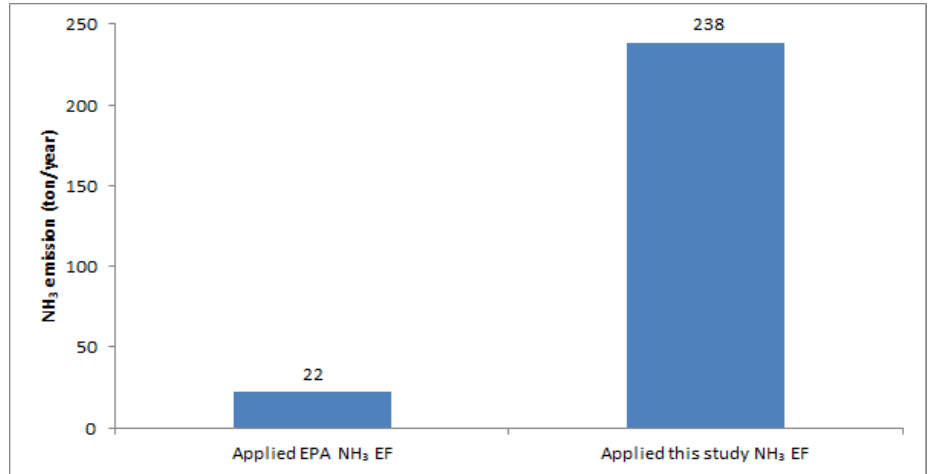
Figure 4. The comparison of NH 3 EF(Emission Factor)for NH 3 emissions at bituminous coal power plants.